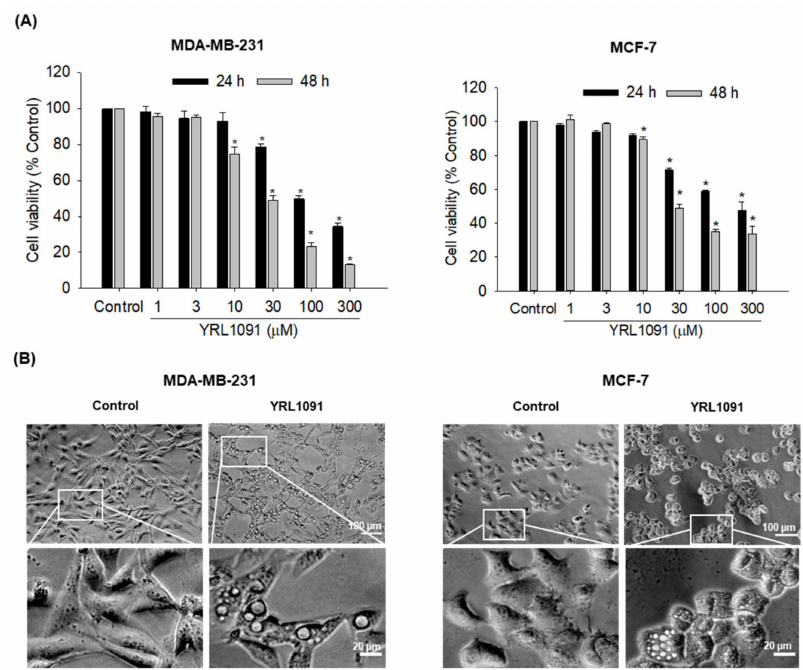
Figure 1. Induction of cytotoxicity and cytoplasmic vacuolization by YRL1091 in MDA-MB-231 and MCF-7 cells. ( A ) Cells were exposed to various concentrations (1–300 µ M) of YRL1091 for 24 and 48 h. Cell viability was measured by SRB assay, as described in Materials and Methods section. The cell viability of each treated group was expressed as the percentage of that in control group and presented as the mean ± SEM from at least three independent experiments. * p < 0.05 vs. the vehicle control. ( B ) Cells were treated with 30 µ M YRL1091 for 24 h, and the control cells were treated with DMSO instead. Changes in cell morphology were visualized using a phase-contrast microscope. Scale bar: 20 µ m. Magnified images of white boxes are also